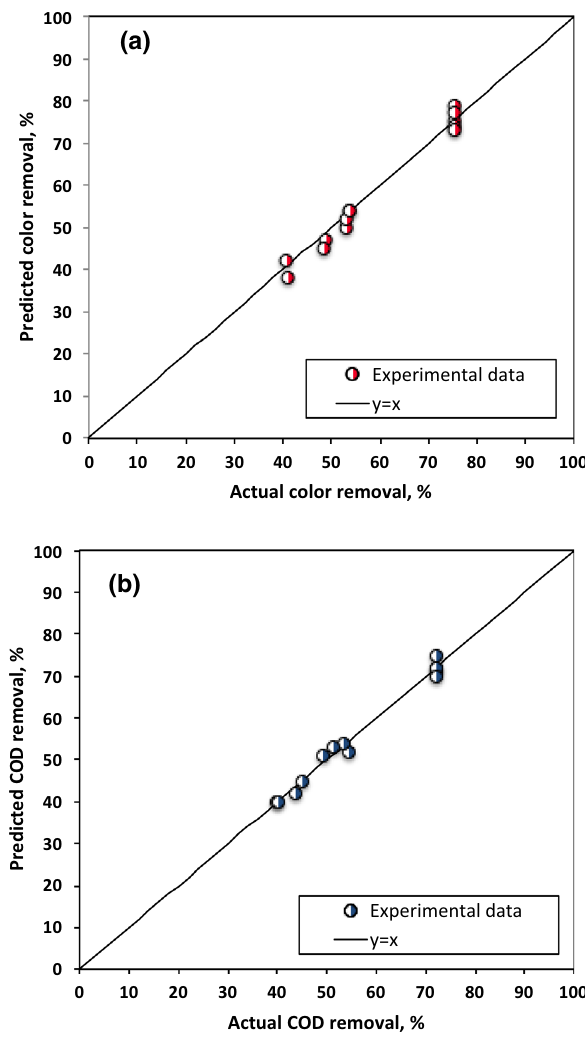
Fig. 2 Comparison between actual and predicted values of models a f 1 model, b f 2